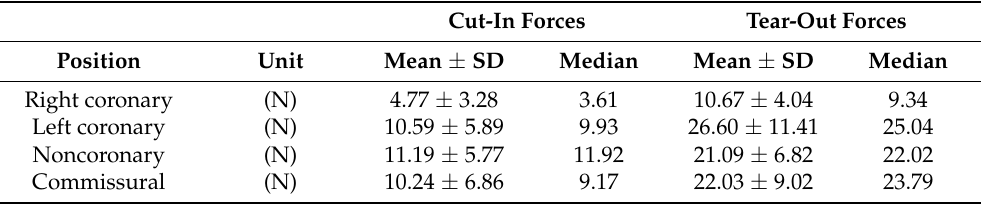
Table 1. Average “cut-in” and “tear-out” forces in relation to the anatomic position of the suture. Cut-In Forces Tear-Out Forces Position Unit Mean ± SD Median Mean ± SD Median Right coronary (N) Left coronary (N) Noncoronary Commissural (N)